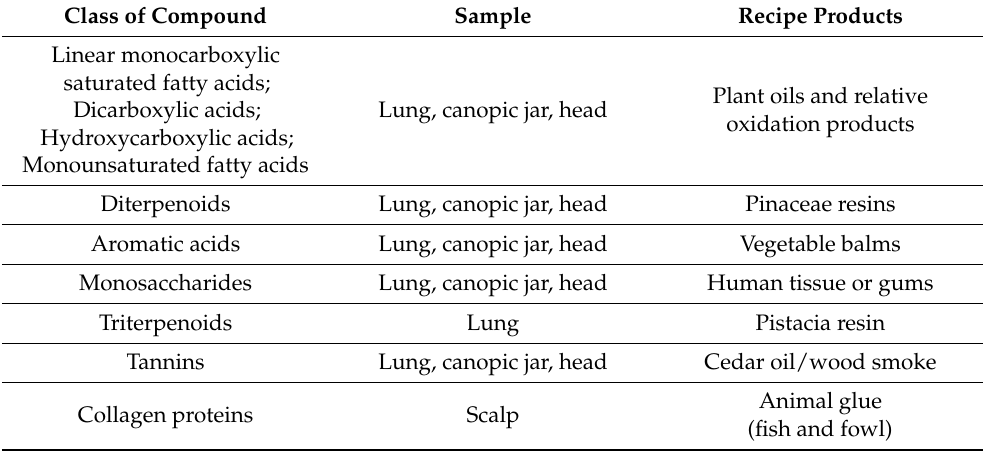
Table 3. Nebiri’s embalming “recipe”: list of main class of compounds associated with the samples and relative